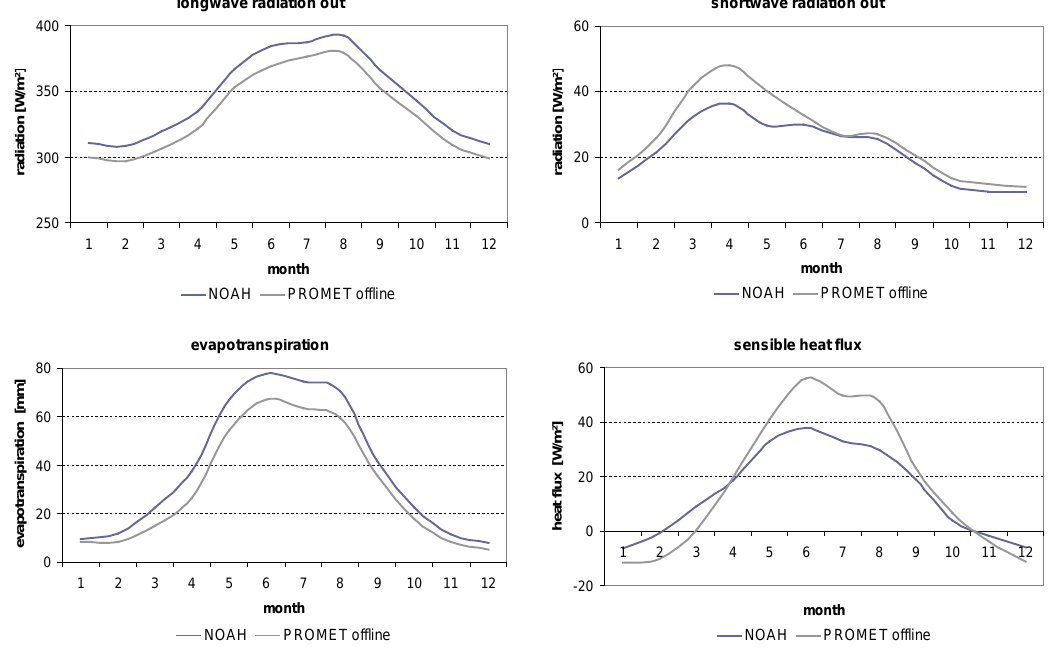
Figure 2: Spatially averaged monthly land surface mass and energy fluxes (long-wave outgoing radiation, short-wave reflection, evapotranspiration, sensible heat flux) for the Upper-Danube catchment simulated with the Noah-LSM and with PROMET respectively for the years 1996- 1999.